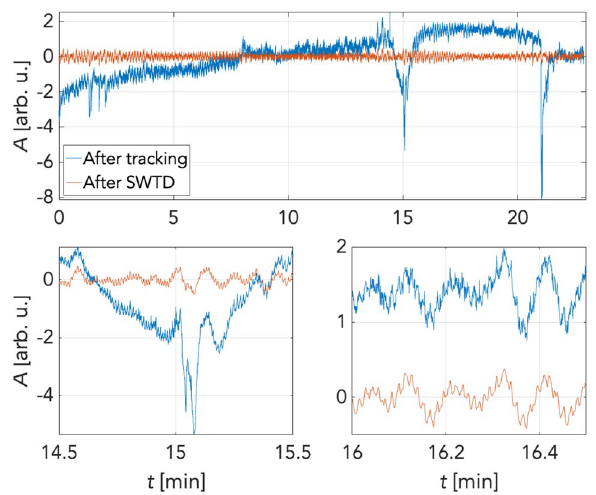
Figure 7. Signal before and after stationary wavelet transform denoising.